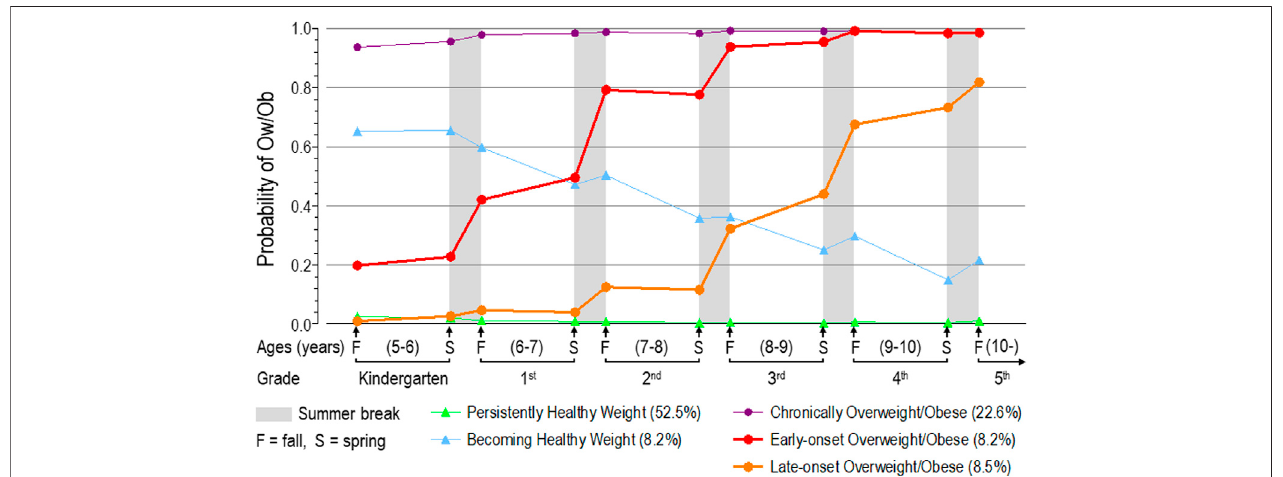
FIGURE 2 | BMI trajectories of probability of overweight/obesity (BMI ≥ 85th percentile).